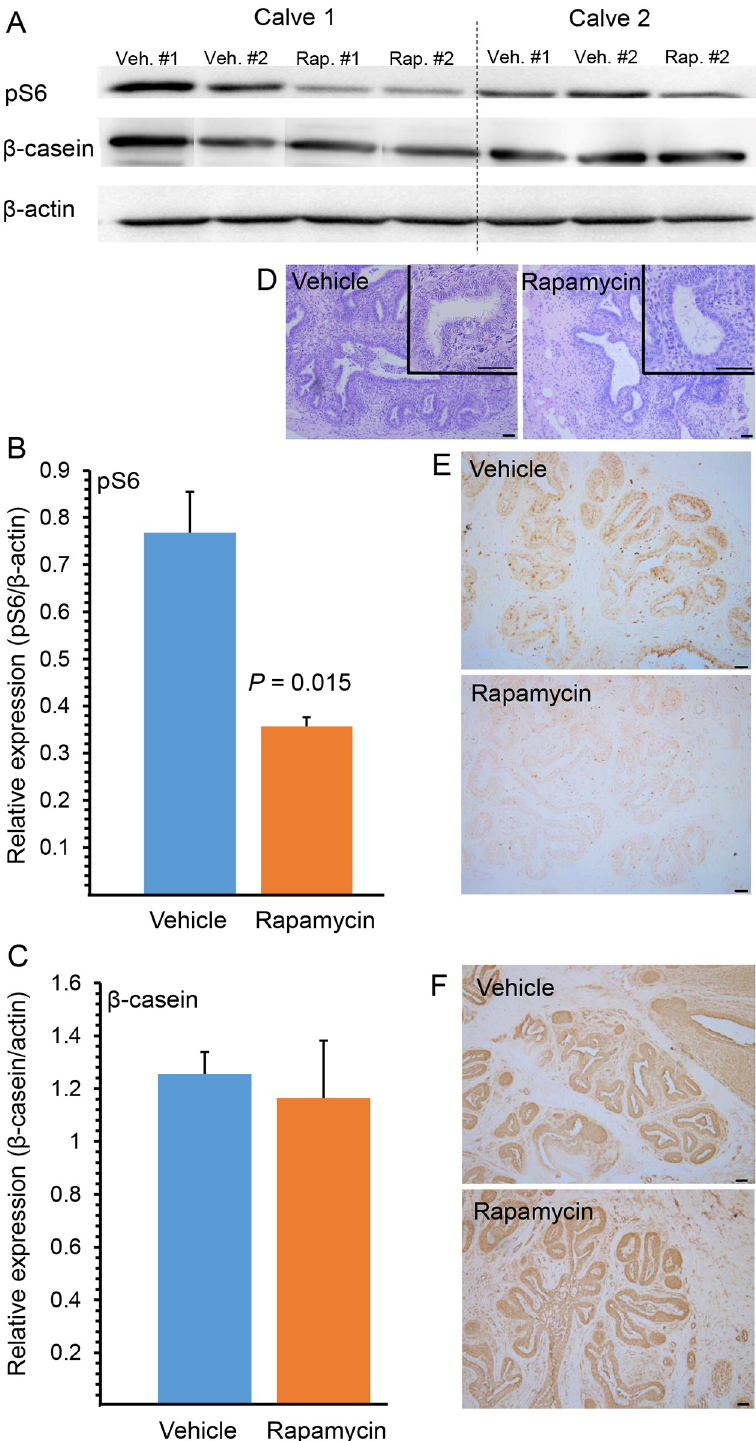
Fig 2. Intramammary rapamycin administration for 3 weeks significantly reduces S6 phosphorylation in the mammary gland with no effect on mammary gland morphology or β -casein synthesis. A. Immunoblot analysis of phosphorylated S6 (pS6) and β -casein. One of the nipples in calf #2 was inaccessible. B. Rapamycin administration causes a decrease in pS6 expression relative to β -actin expression (see A). C. Rapamycin administration does not affect β -casein expression relative to β -actin expression (see A). Bar graphs represent mean ± SEM of 3–4 replications. D.